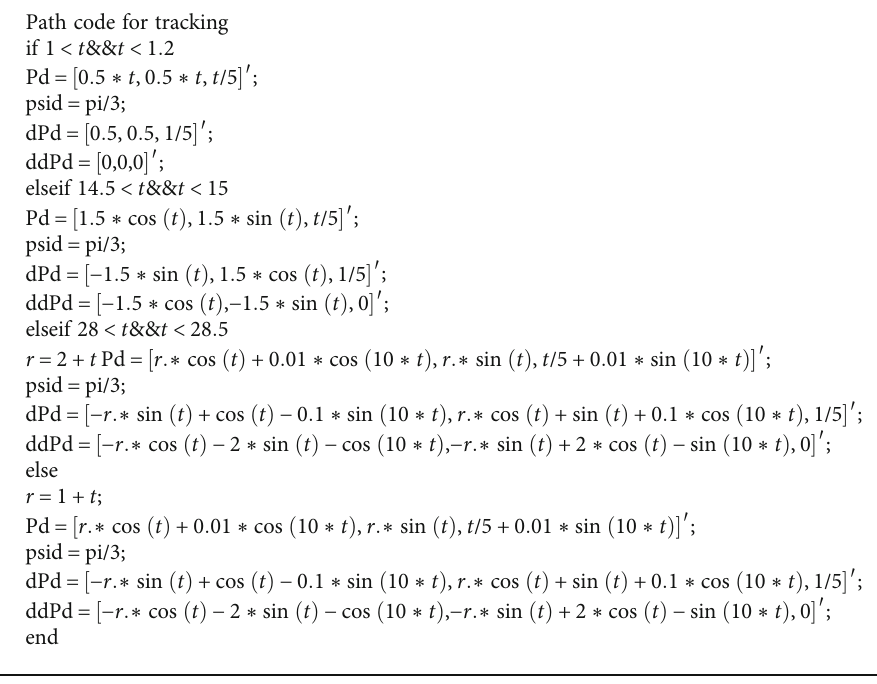
Procedure 2: Path code for